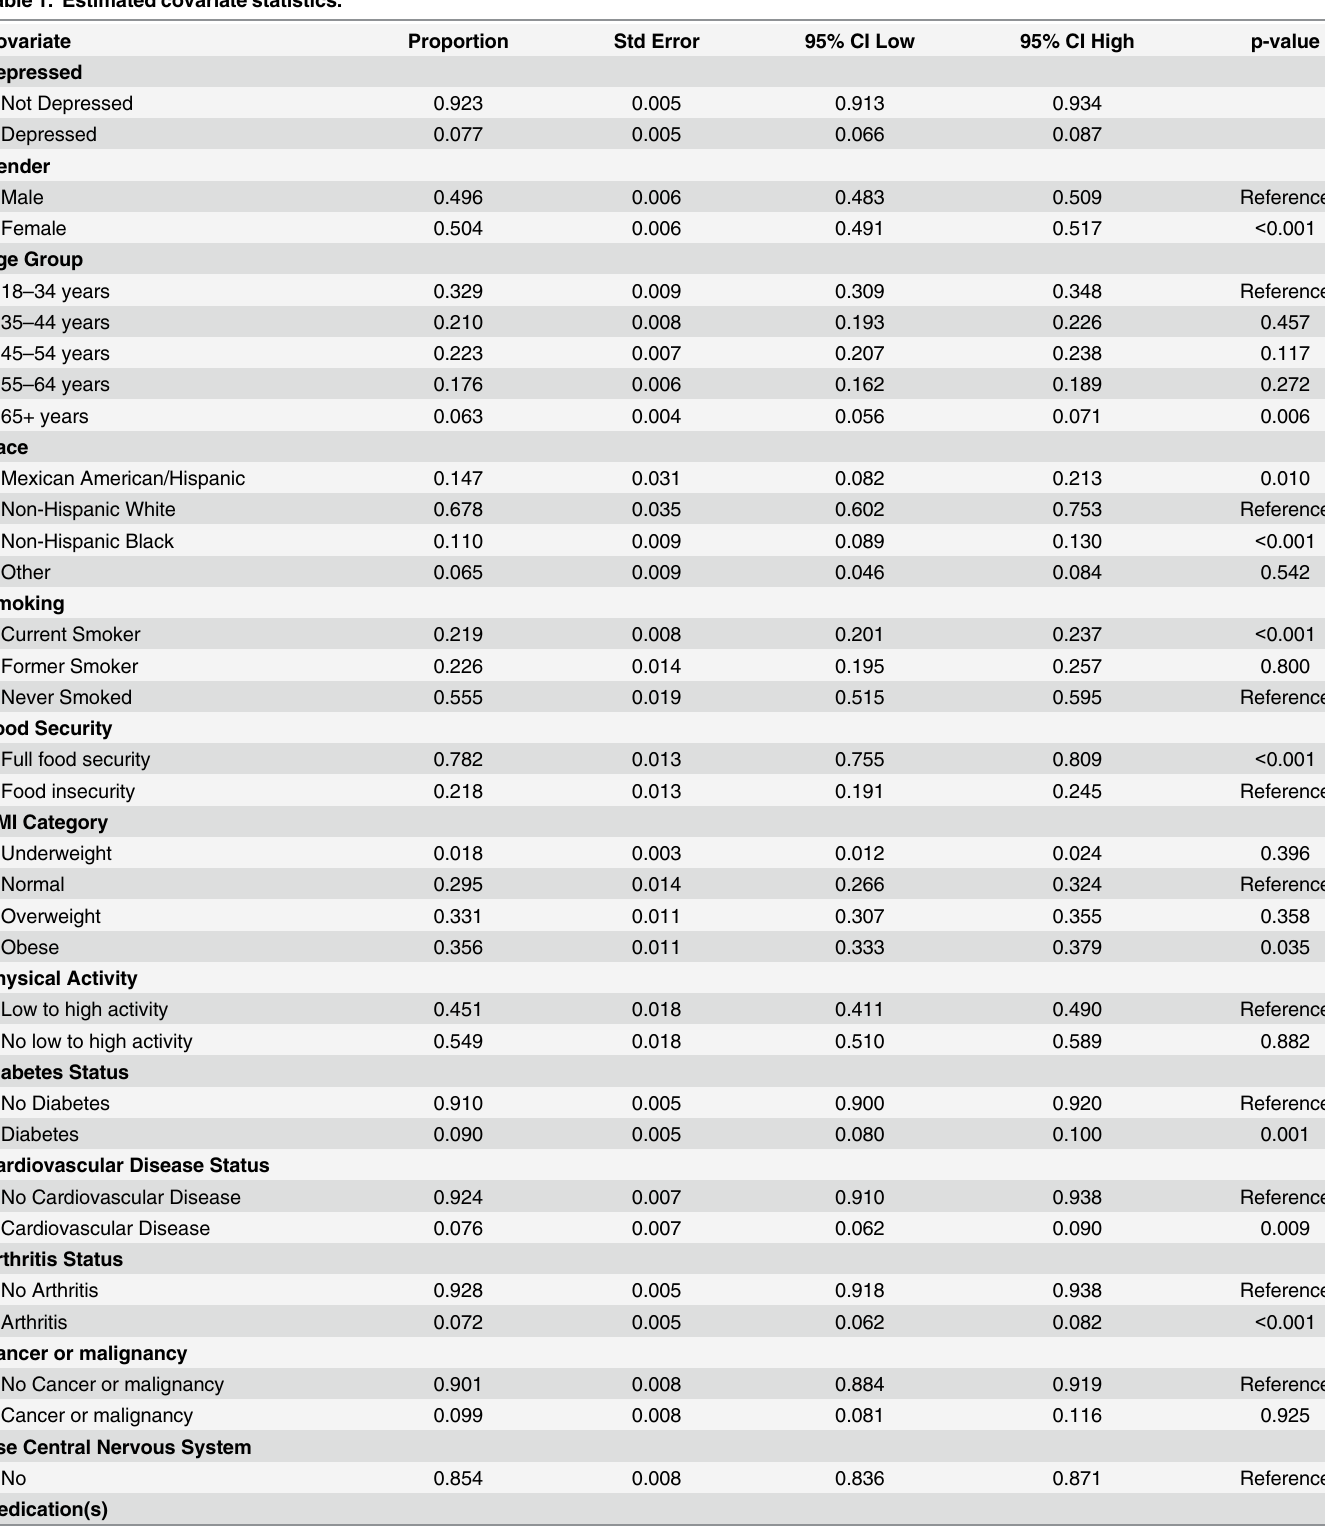
Table 1. Estimated covariate